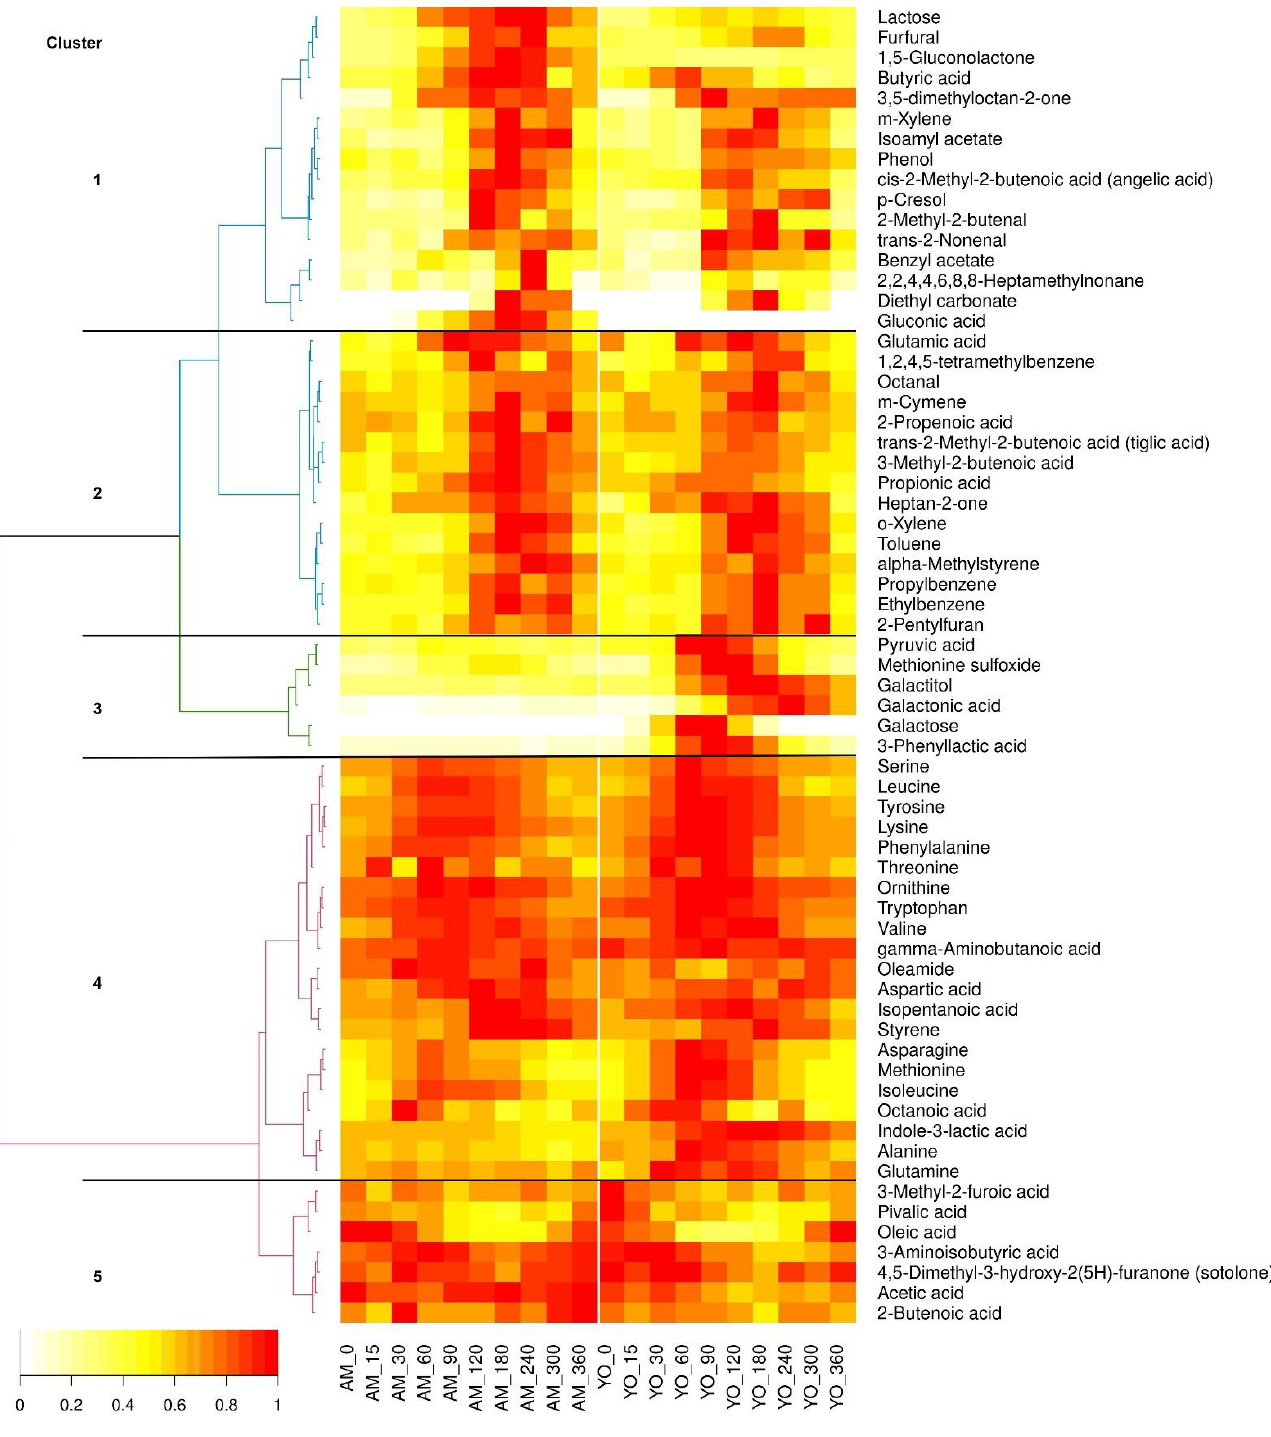
Figure 2. Heatmap with kinetics of 65 targeted postprandial active compounds in serum after con- sumption of milk (AM) and yogurt (YO) from 0 to 360